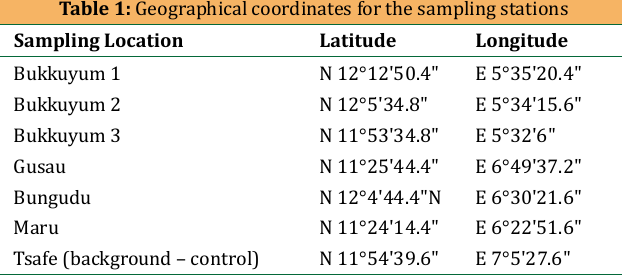
Figure 4: Map of Zamfara State depicting the study area Table 1: Geographical coordinates for the sampling